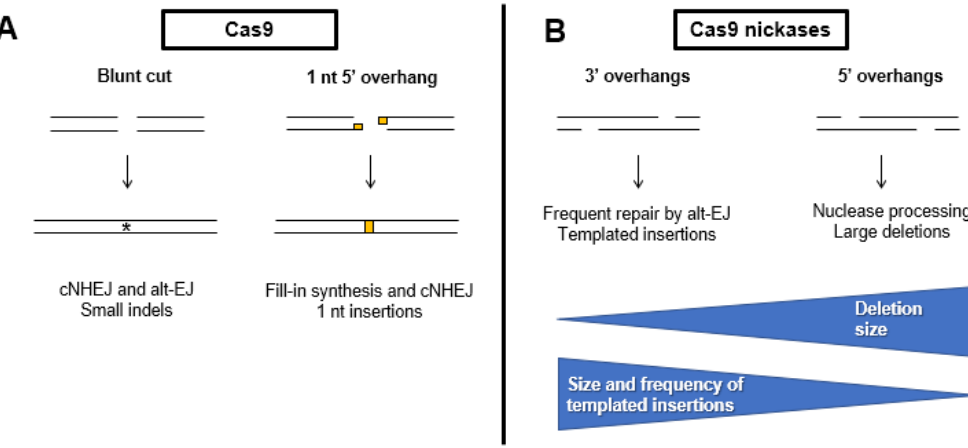
Figure 4. Mutagenic outcomes of Cas9-mediated genome editing. ( A ) Cas9-mediated double-strand breaks are usually blunt-ended and can be repaired inaccurately by cNHEJ and alt-EJ. Occasionally, Cas9 leaves 5 (cid:48) single-stranded overhangs that are filled in, resulting in a single nucleotide insertion. ( B ) 3 (cid:48) overhangs produced by Cas9 nickases are often repaired by alt-EJ, creating large, templated insertions. In contrast, 5 (cid:48) overhangs are processed by nucleases to produce substrates suitable for alt-EJ and HR, sometimes resulting in large